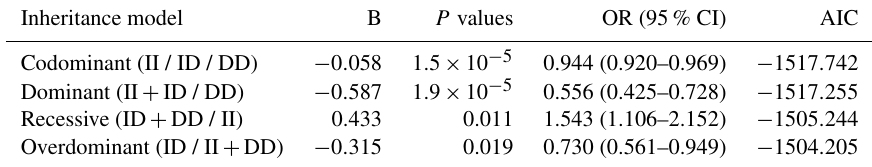
Table 5. Different genetic models of PITX2 indel in mothers of single-kid and multi-kid Shaanbei white cashmere (SBWC) goats. Inheritance